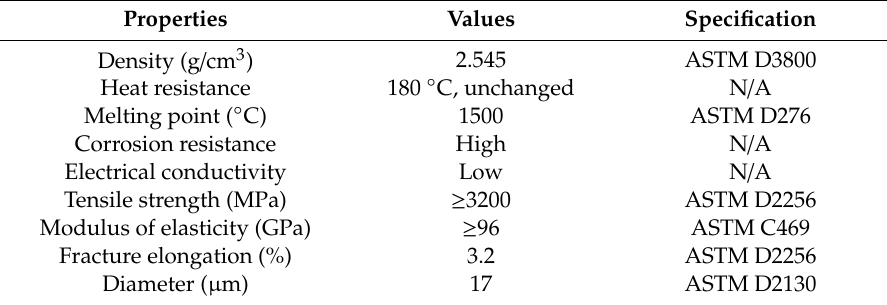
Table 2. Properties of basalt fiber (provided by manufacturers).